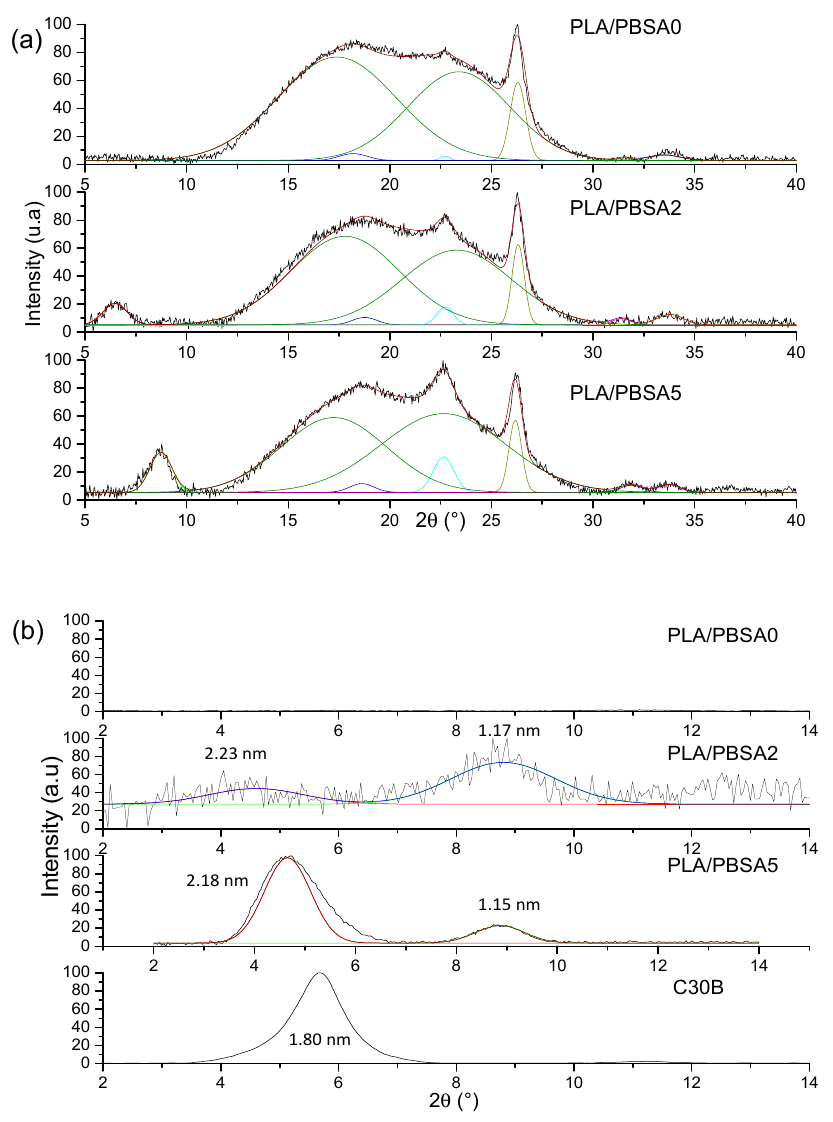
Figure 8. XRD spectra for the PLA/PBSA, PLA/PBSA2 and PLA/PBSA5 multilayer films in the 5–40° range ( a ) and for C30B powder in 2–14° range ( b ).